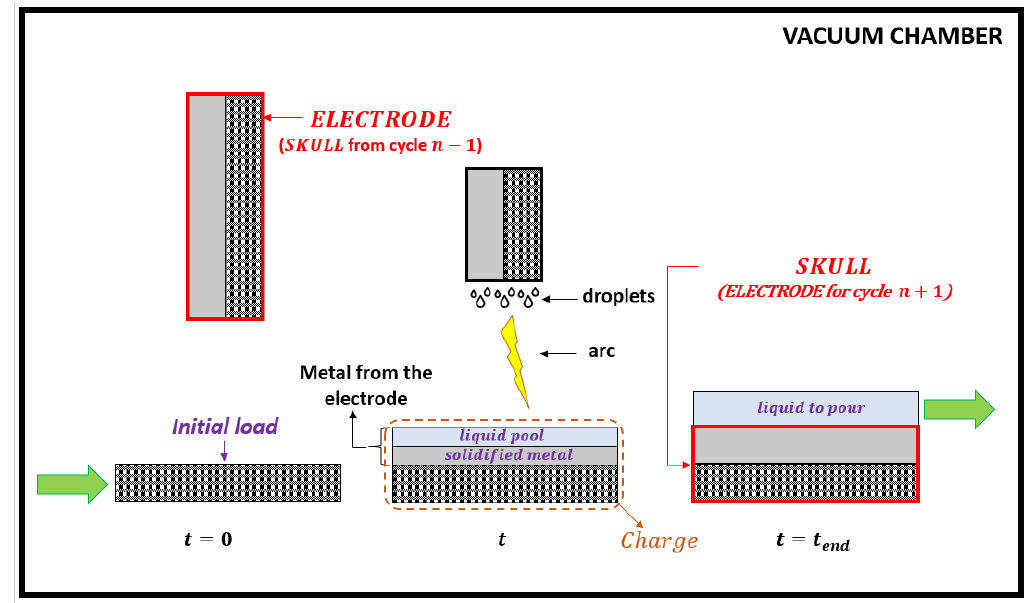
Figure 1. Schematics of the melting cycle of the VASM process.